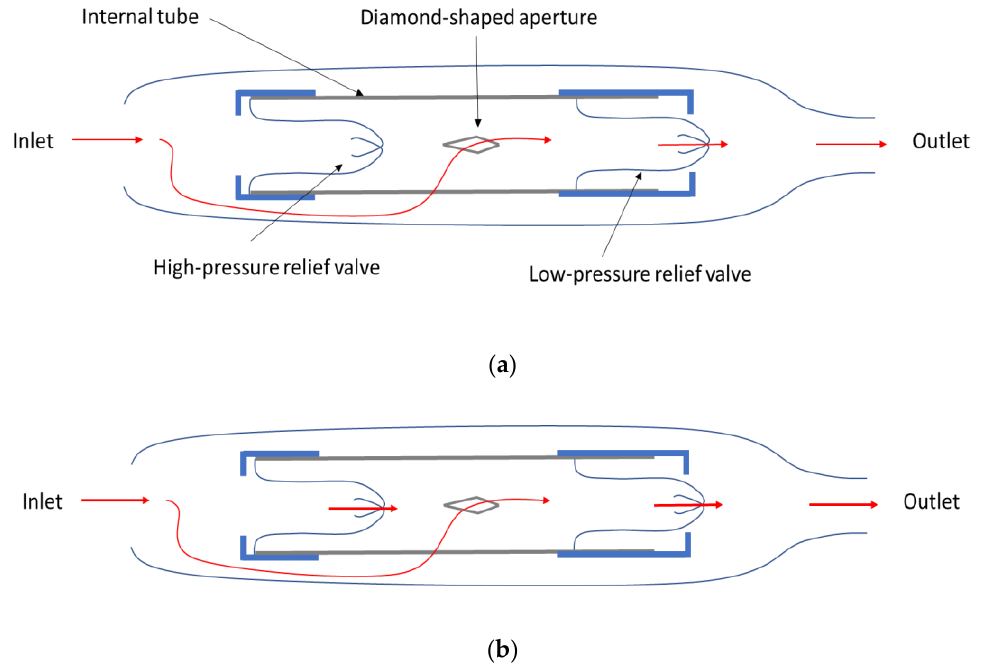
Figure 11. Schematic drawing of the CRx Diamond Valve, a flow control hydrocephalus shunt. The arrows indicate the flow direction. ( a ) Flow regulation stage, i.e., for pressure in the range [ 18.6;30.6 ] mbar. The CSF flows through the diamond-shaped aperture that narrows as the pressure increases to induce nonlinearity and through the low-pressure relief valve. ( b ) High-pressure or safety stage. The high-pressure relief valve opens to drain the excess of CSF through the large channel and the low-pressure relief valve.